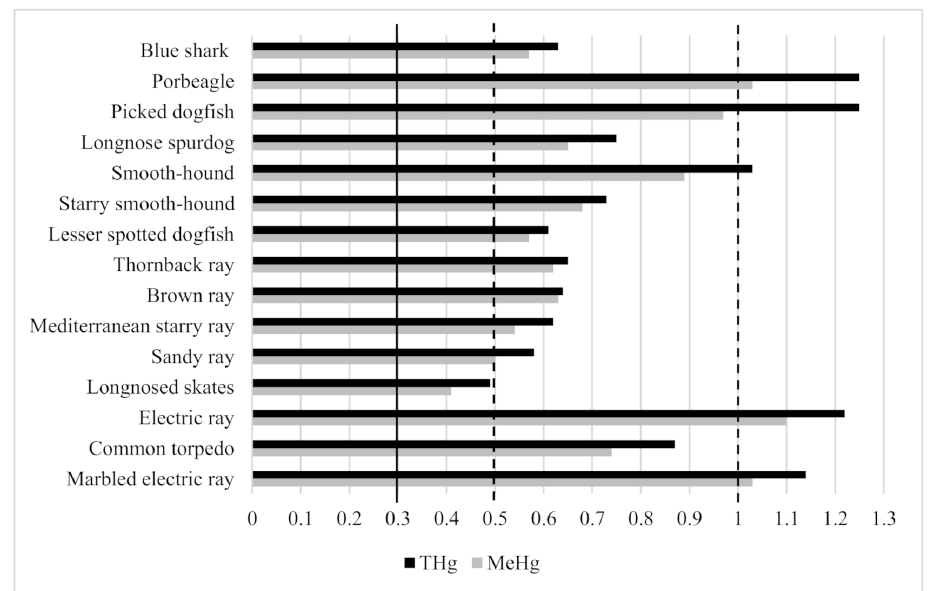
Figure 1. Concentrations of total mercury (THg) and methylmercury (MeHg) in fish muscle tissue in comparison to international guidelines. Dashed black lines: maximum concentration of THg (0.5 and 1 µ g g − 1 w.w.) [62,63]; black line: maximum concentration of MeHg (0.3 µ g g − 1 w.w.)